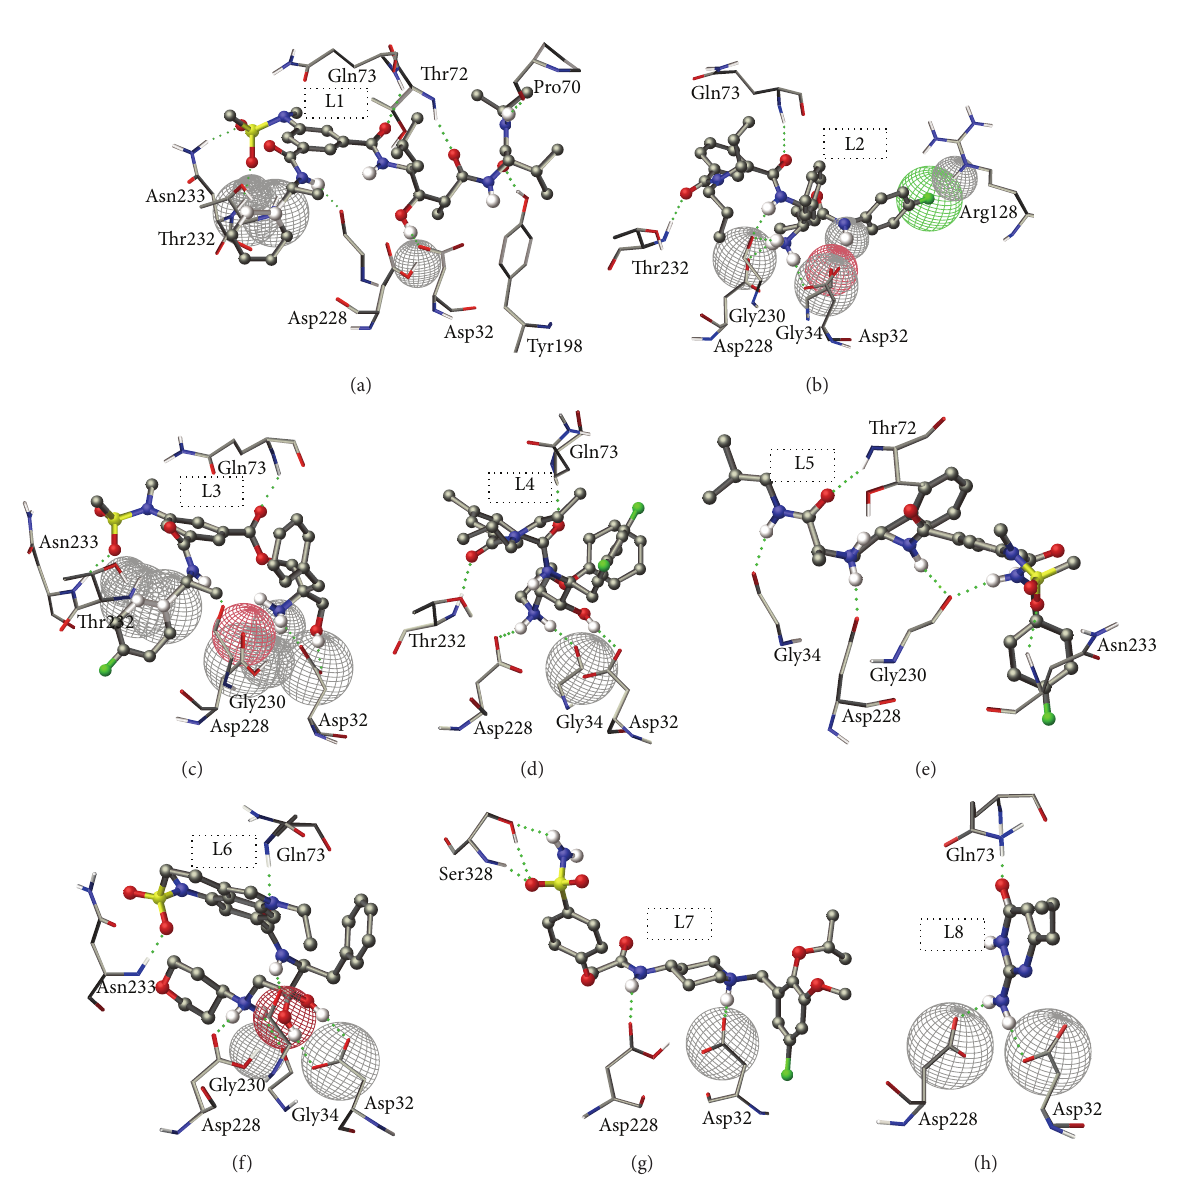
Figure 6: Most favorable binding modes of the ligands L1–L8 ((a) to (h), resp.) obtained from the docking